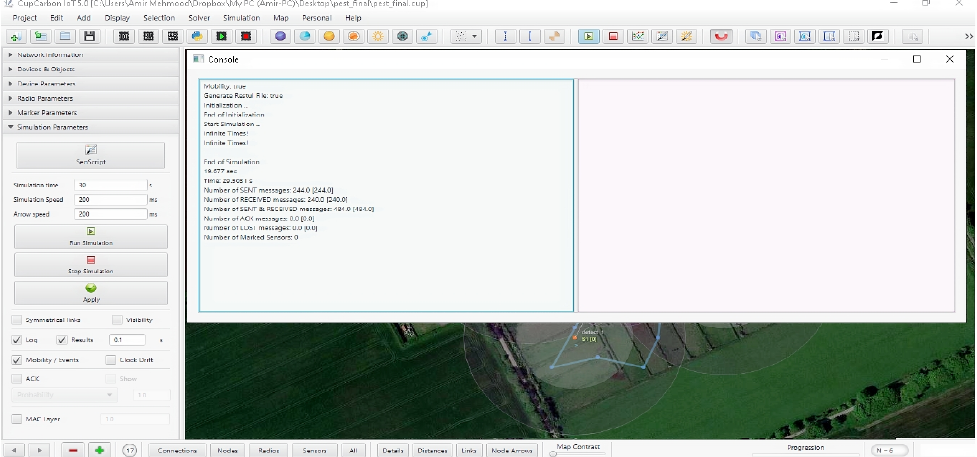
Figure 13. ( A , B ) The drone movement is visible in different clusters as the multi-hop environment increased the sensing range.